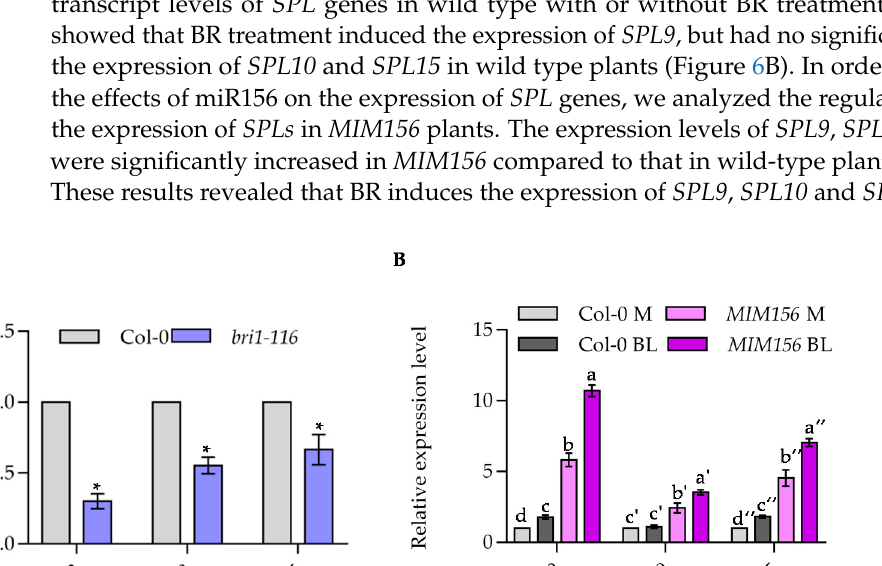
MS medium under 2